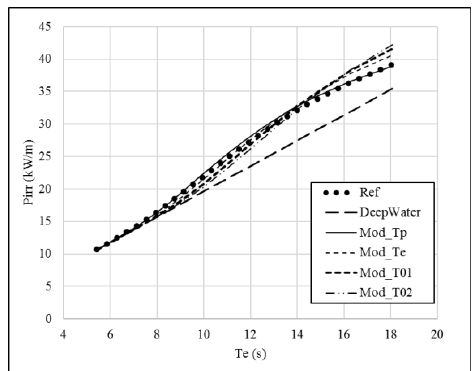
Figure 12. Modifications of the wave energy assessments using different characteristic periods ( h = 50 m).